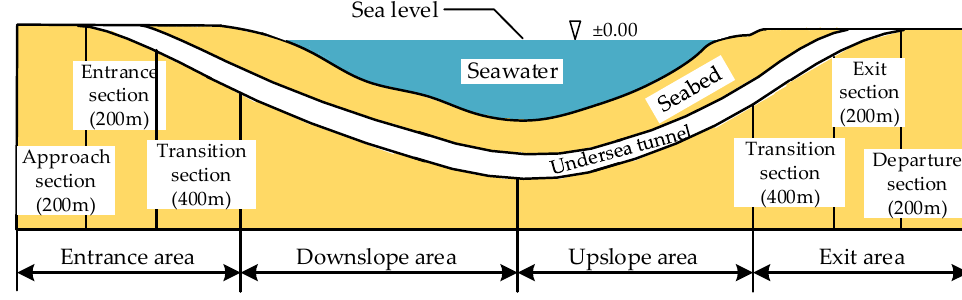
Figure 1. The area division of the undersea tunnel.